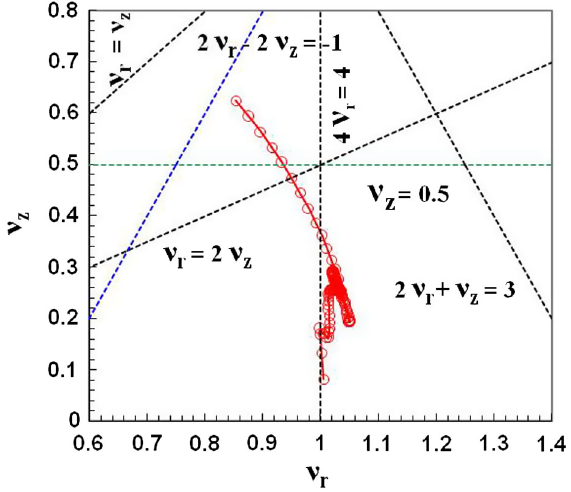
FIG. 13. Tune diagram and resonance